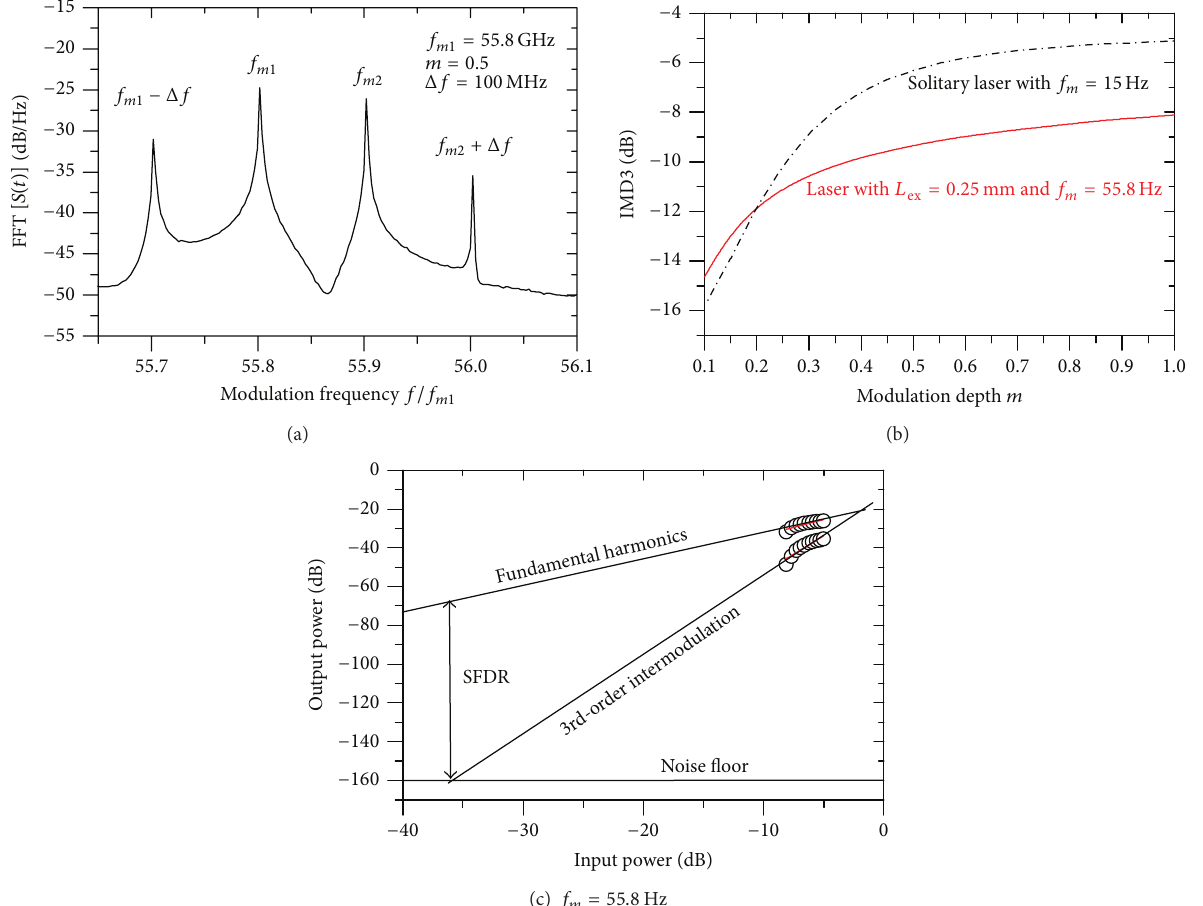
Figure 6: Characteristics of two-tone modulation with 𝑓 𝑚1 = 55.8 GHz and Δ𝑓 = 100 MHz: (a) FFT power spectrum showing the intermodulation components at 𝑓 𝑚1 − Δ𝑓 and 𝑓 𝑚2 + Δ𝑓 , (b) influence of modulation depth 𝑚 on the IMD3, and (c) SFDR determination, SFDR = 73 dB/Hz 3/2